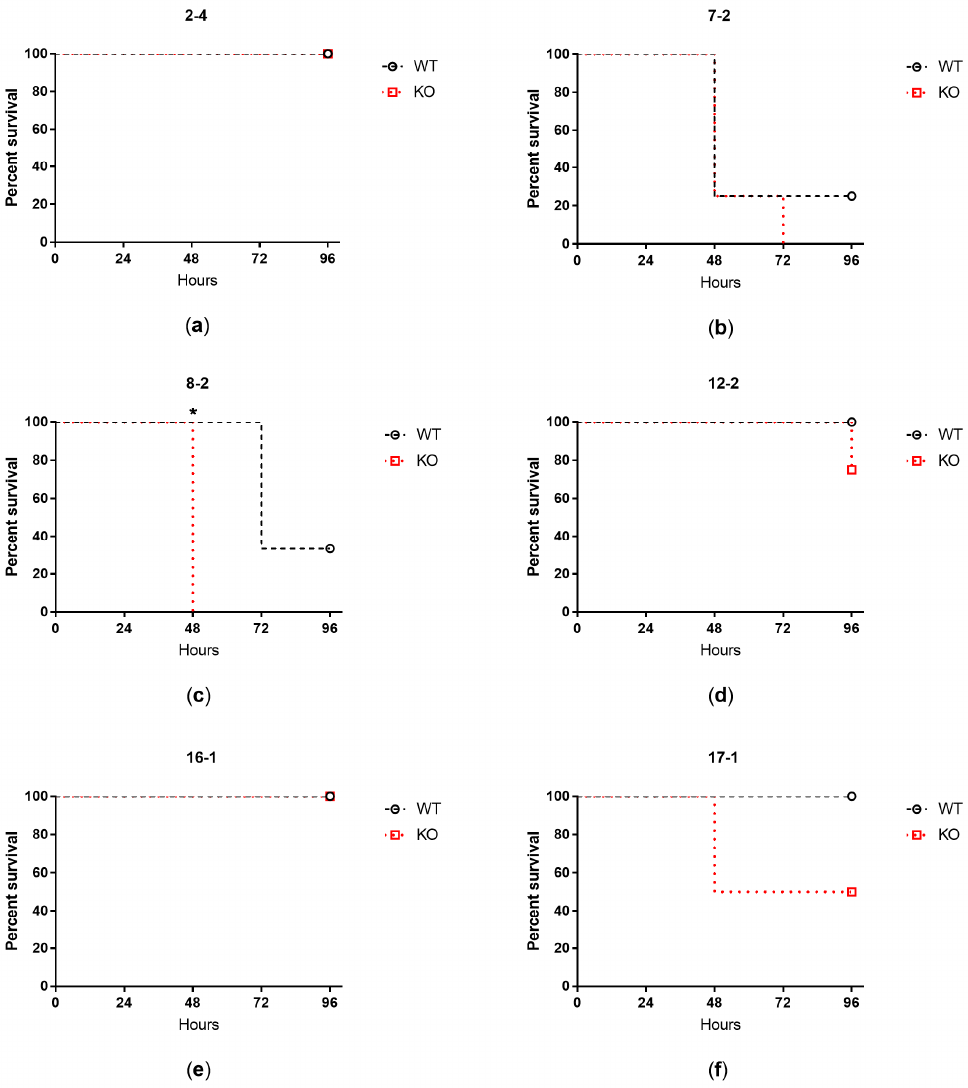
Figure 4. Percent survival of WT and KO mice up to 96 h after intratracheal challenge with each clinical isolate: 2-4 ( a ), 7-2 ( b ), 8-2 ( c ), 12-2 ( d ), 16-1 ( e ), 17-1 ( f ), 20-1 ( g ), 23-1 ( h ). The mean of four mice per group is shown. Statistical analysis was performed by log-rank test; * p < 0.05.